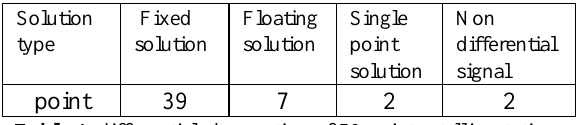
Table 3. accuracy setting of four differential modes